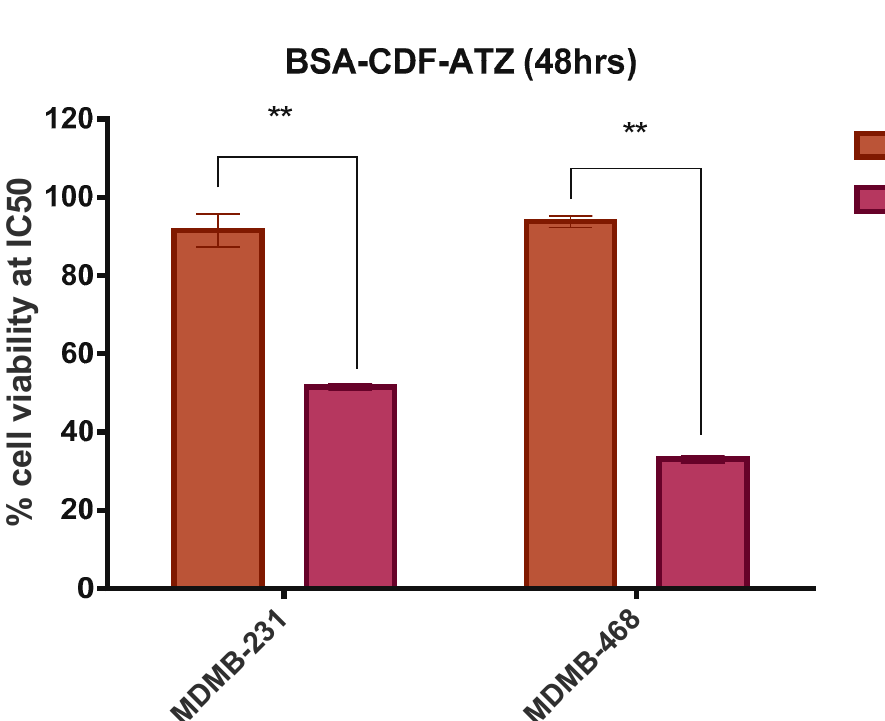
Figure 7. Comparative in vitro cytotoxicity studies for normoxic and hypoxic conditions in MDA-MB-231 and MDA-MB-468 cell lines respectively, for BSA-CDF-ATZ. In both the cell lines, the uptake was higher in the hypoxic condition. Experiments were performed in triplicates; results are shown mean ± SD; **P ≤ 0.01.